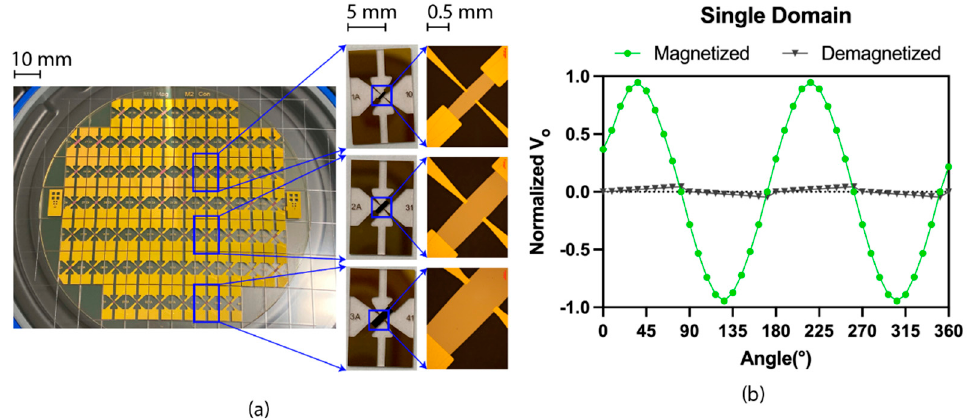
Figure 3. ( a ) 62 sensors in 4–inch glass wafer after dicing and three sensor variants based on the sensing area with the microscopic image; ( b ) effective single-domain behaviour of the sensor variants. The dots indicate the mean of the normalized V o (n = 9, 1 pc sensor for each variant), which was measured as a function of the angle ( θ ) between the excitation current (I = 50 mA) and magnetization (H = 10 Oe). Paired demagnetized (H = 0 Oe) measurements were made for each magnetized measurement.